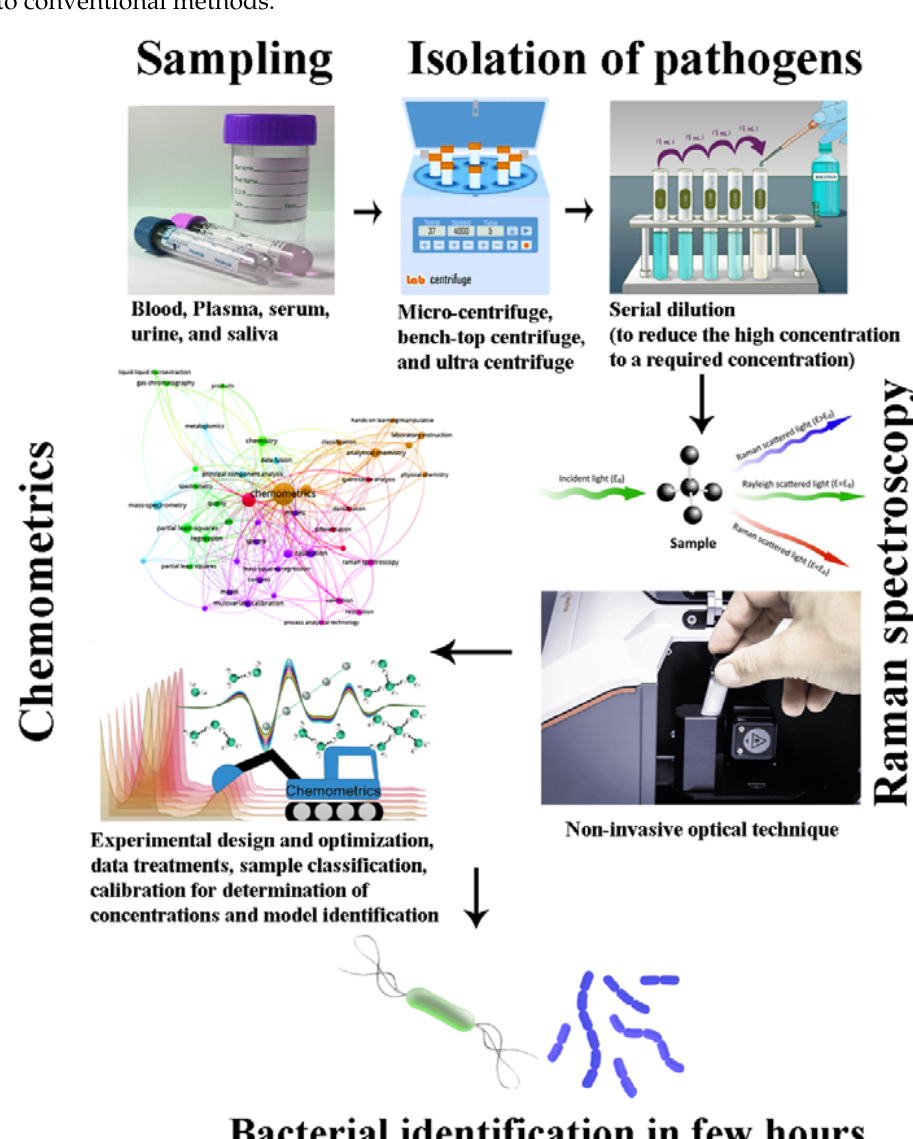
Figure 4. Spectroscopy and machine learning methods for the detection of bacterial pathogens.